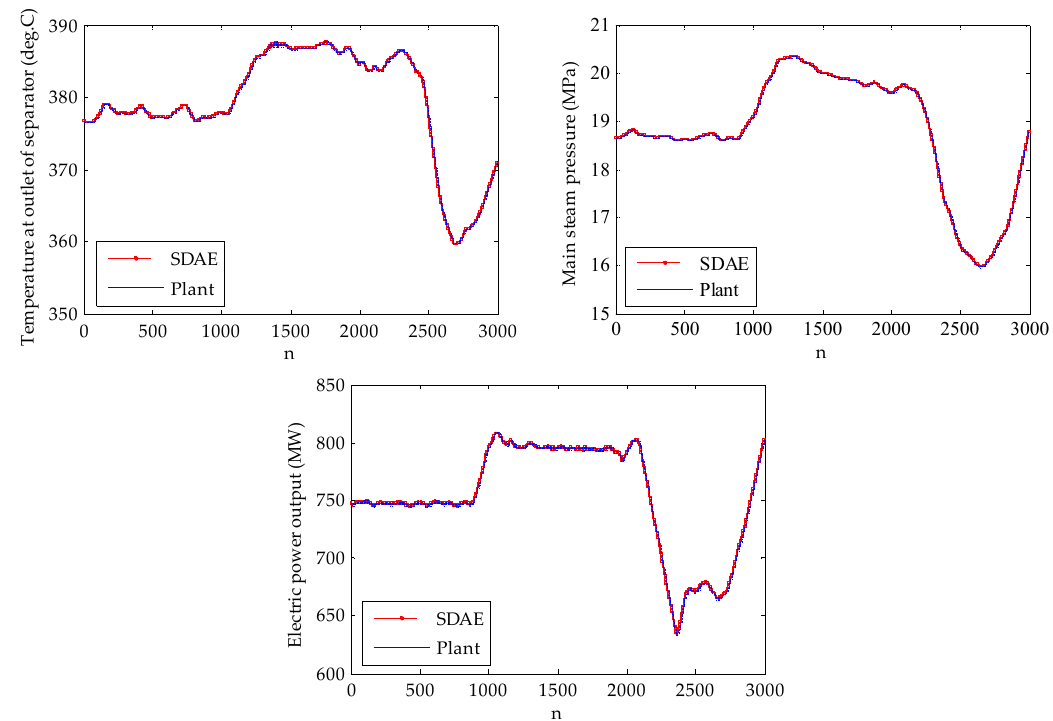
Figure 10. A comparison of the boiler system and the SAE model (validating).